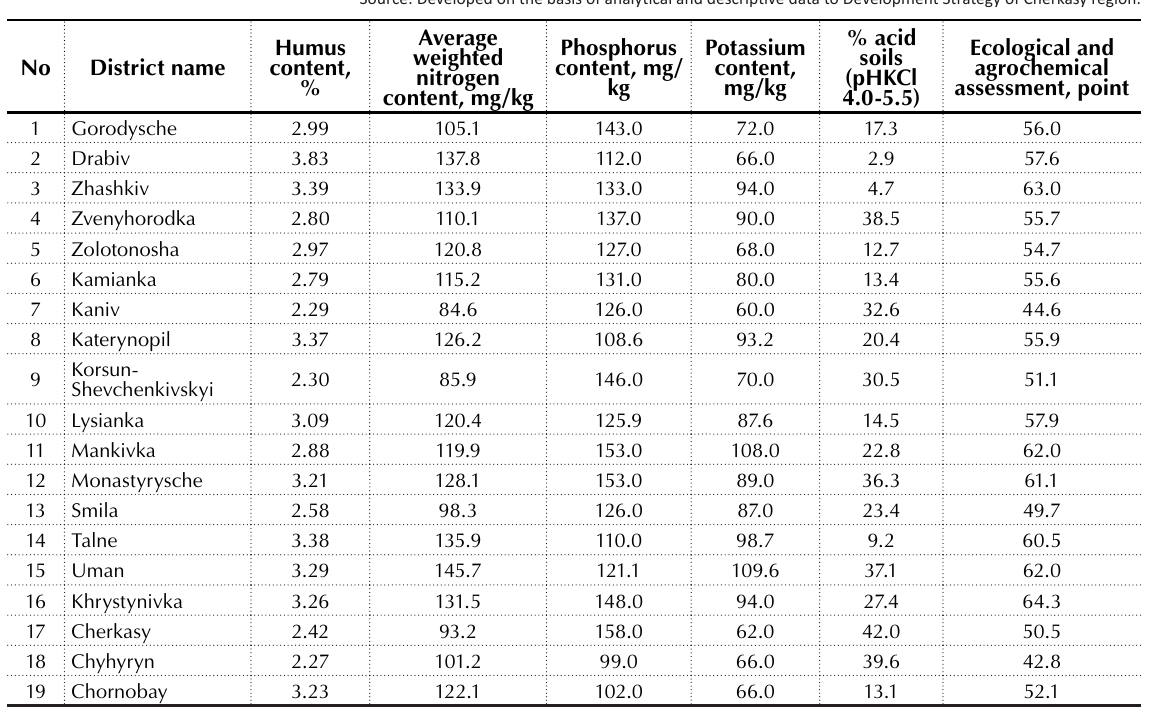
Table 4. Quality of agricultural soils within Cherkasy region Source: Developed on the basis of analytical and descriptive data to Development Strategy of Cherkasy